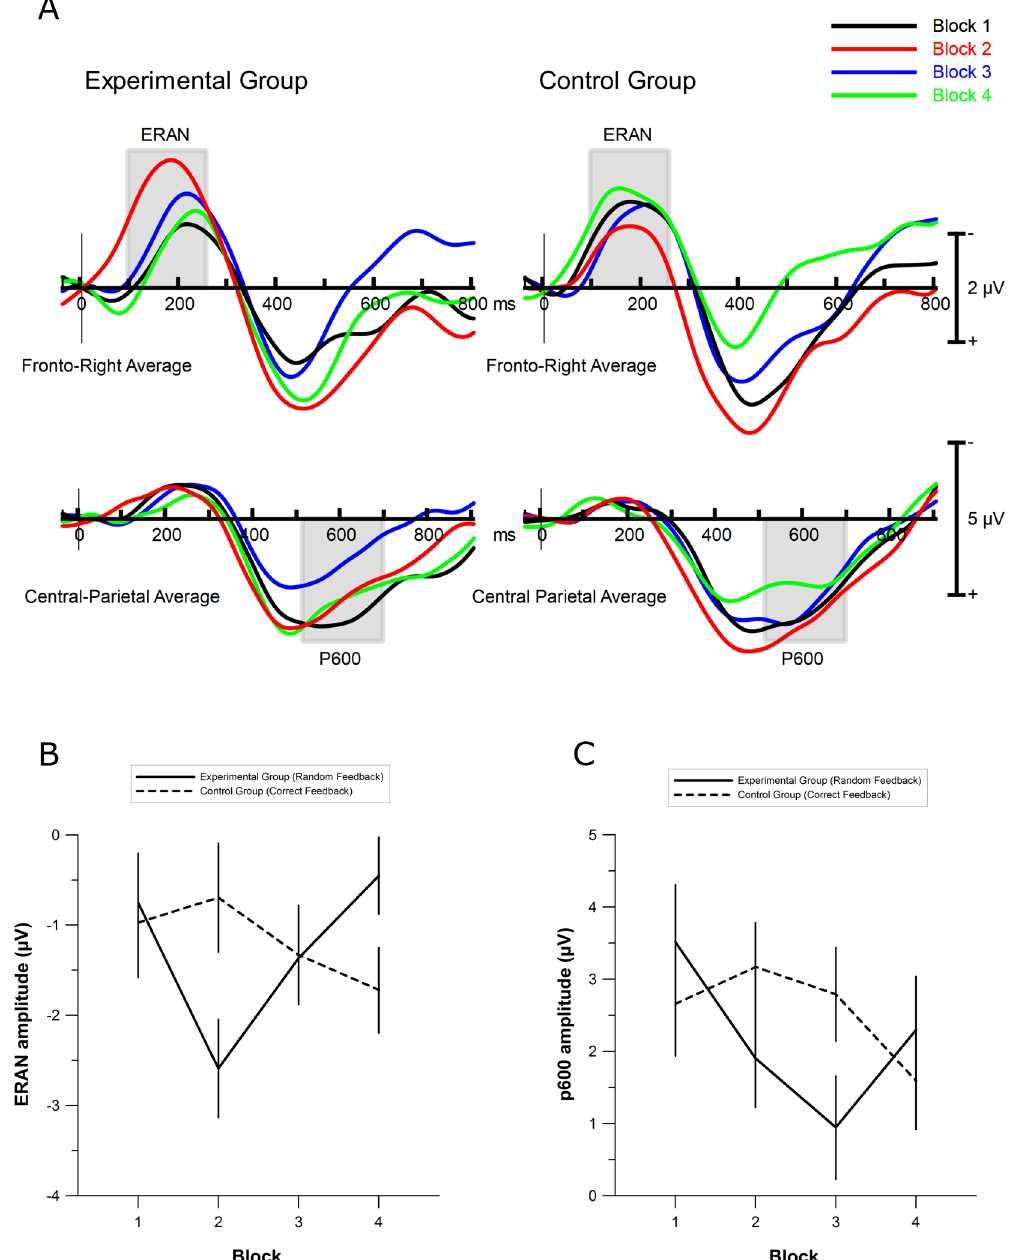
Block 4 = Recovery. For the control group, Block 1 = Baseline, Block 2 = Correct Feedback 1, Block 3 = Correct Feedback 2, Block 4 = Correct Feedback